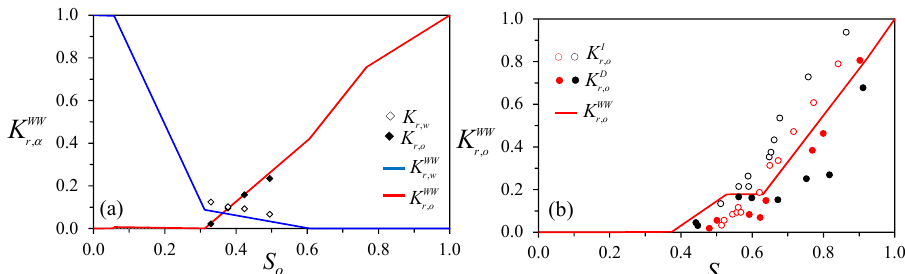
Figure 9. Comparison between relative permeability curves associated with our computational analyses (curves) and data from experimental studies on micromodels (symbols) of ( a ) Avraam and Payatakes [13]; and ( b ) Chang et al. [50]. Red and black symbols in ( b ) are respectively associated with a Water/Diesel fuel system and Water / Tetrachloroethane tests. Open and solid circles respectively correspond to imbibition and drainage experiments (corresponding relative permeabilities are respectively indicated with superscripts I and D ).